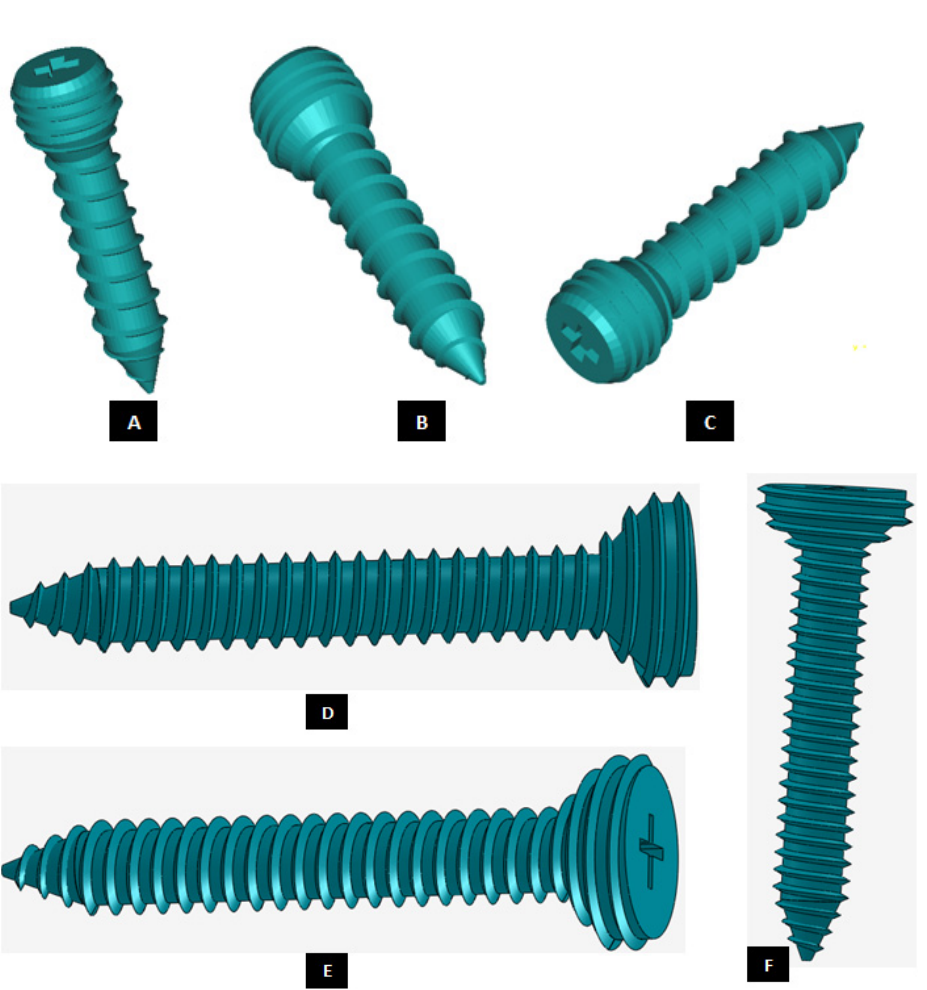
Figure 22. Custom-designed screws with locking mechanism. The threads on the screw-head surface provide improved/optimal fixation by firmly engaging in the matching threads in the screws holes of either condylar/ramal or fossa component of the total TMJ prosthesis ( A – F ). Titanium alloy (Ti-6Al-4V) for condylar/ramus component and bone screws,